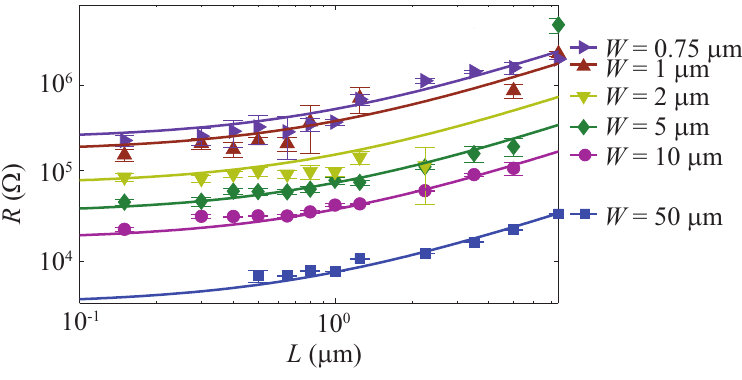
Figure B1. The measured (symbols) and calculated (solid lines) resistance of VO a function of L for several values wire W